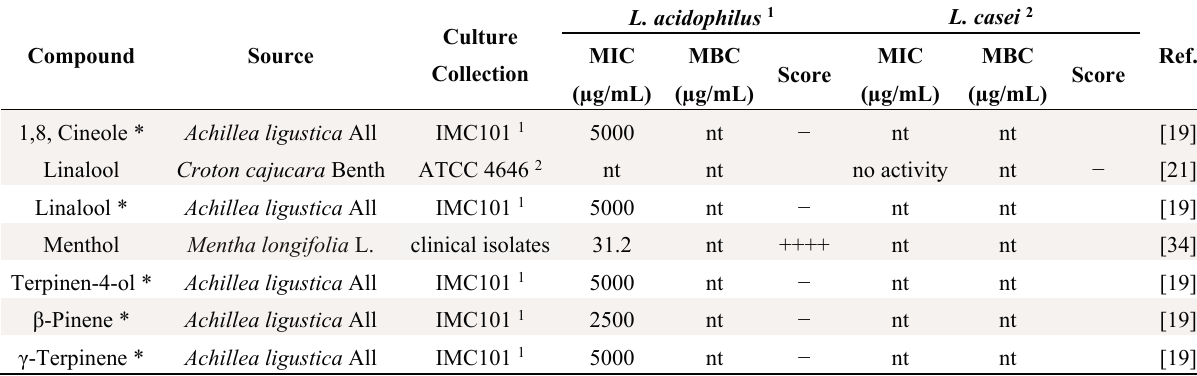
Table 5. Essential oils isolated compounds against